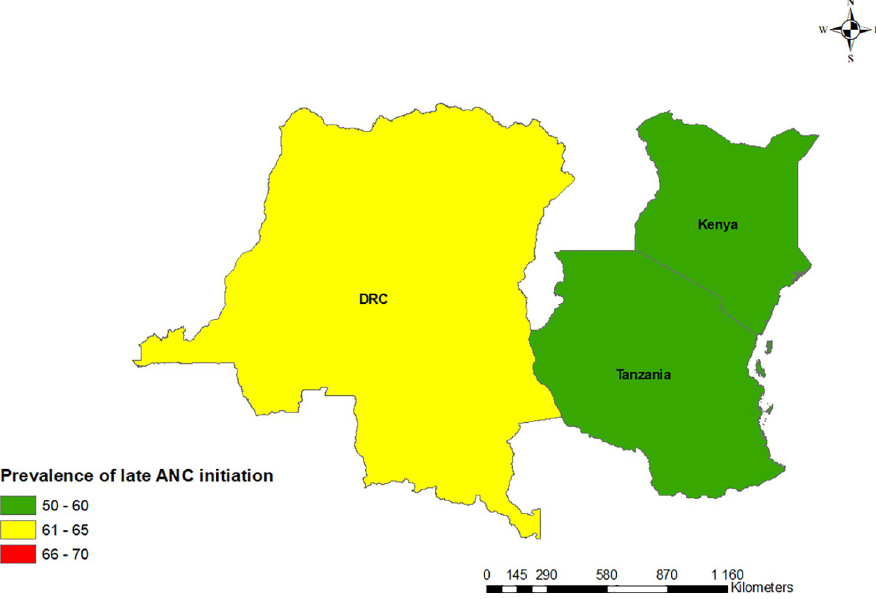
Fig 2. Map showing the prevalence of late ANC initiation in the DRC, Kenya, and Tanzania second survey in this study. Base map source at https://spatialdata.dhsprogram.com.